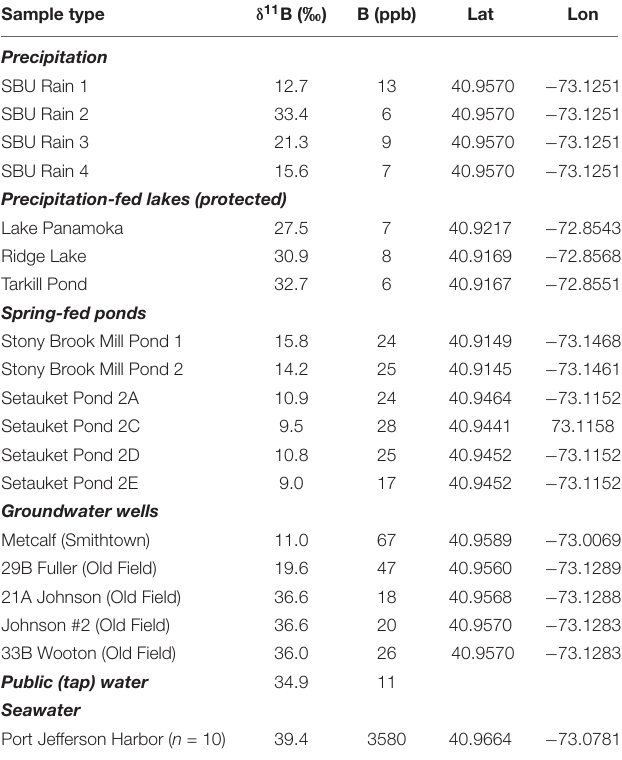
TABLE 1 | Summary of B concentration and δ 11 B isotopic values for natural waters, including precipitation, protected precipitation-fed lakes, spring-fed ponds, groundwater wells, public tap water, and seawater.